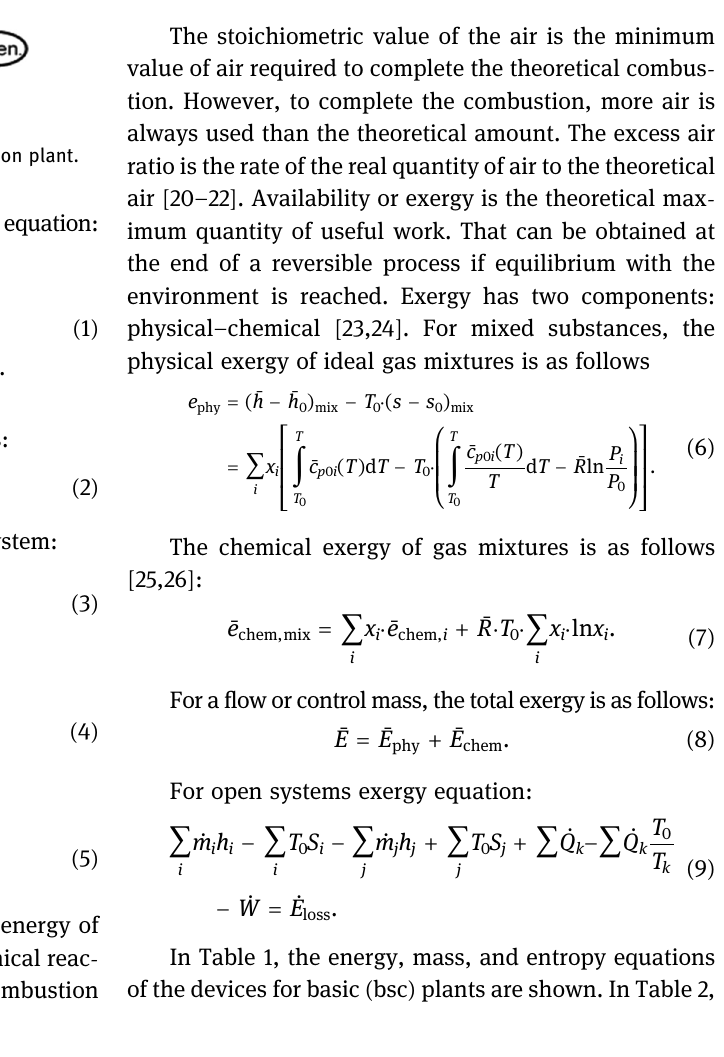
Table 1: Energy, mass, and entropy equations of the devices for basic ( bsc ) plant [ 8,11 – 16 ]